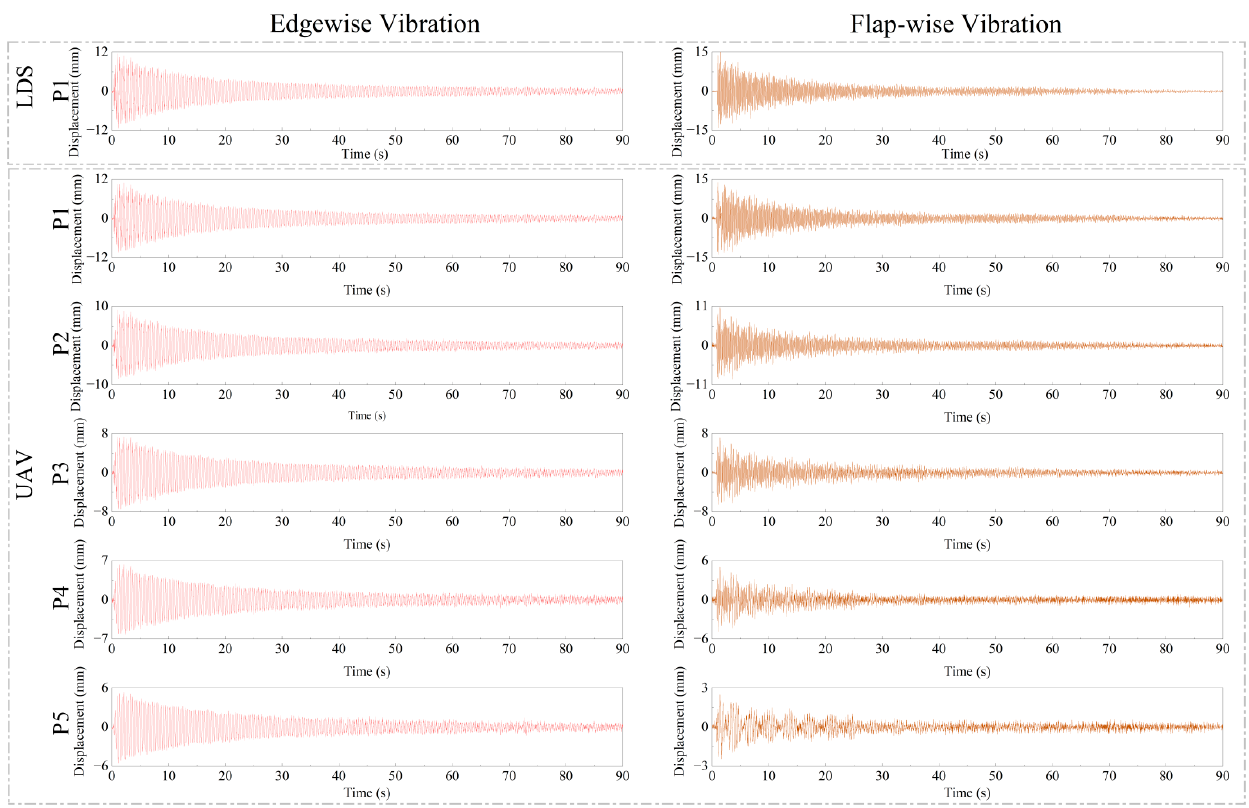
Figure 22. Schematic diagram of multi-point visual verification device. Give the blade excitation at P1 to make it vibrate freely, the five points shown in Figure 22 are monitored visually, and the displacement time history monitored by LDs and vision is shown in Figure 23. The displacement time history peak values obtained by visual monitoring at the five monitoring points are shown in Table 3.